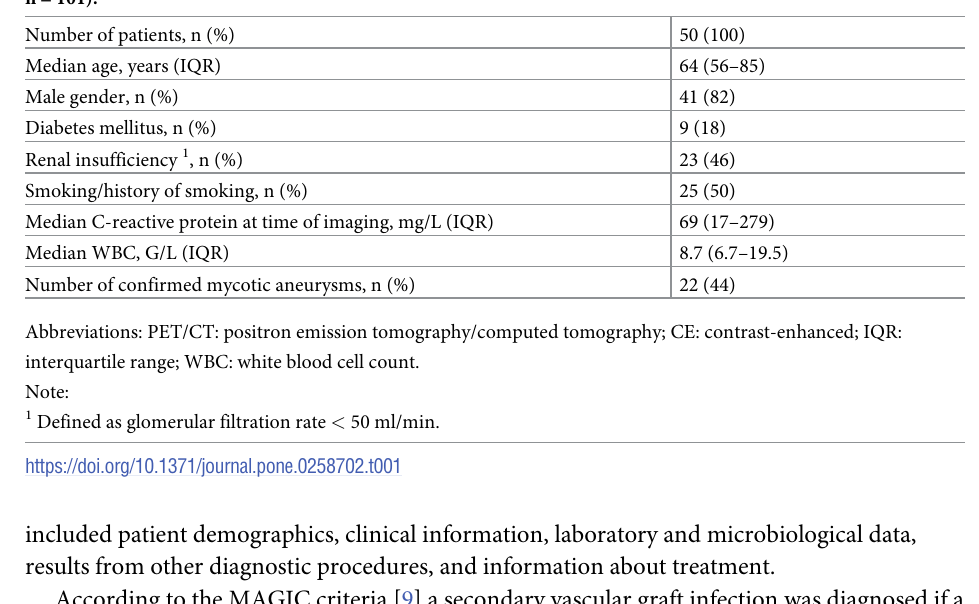
Table 1. Patient demographics at the time of the baseline PET/CT (total number of PET/CT examinations n = 101). Number of patients, n (%)